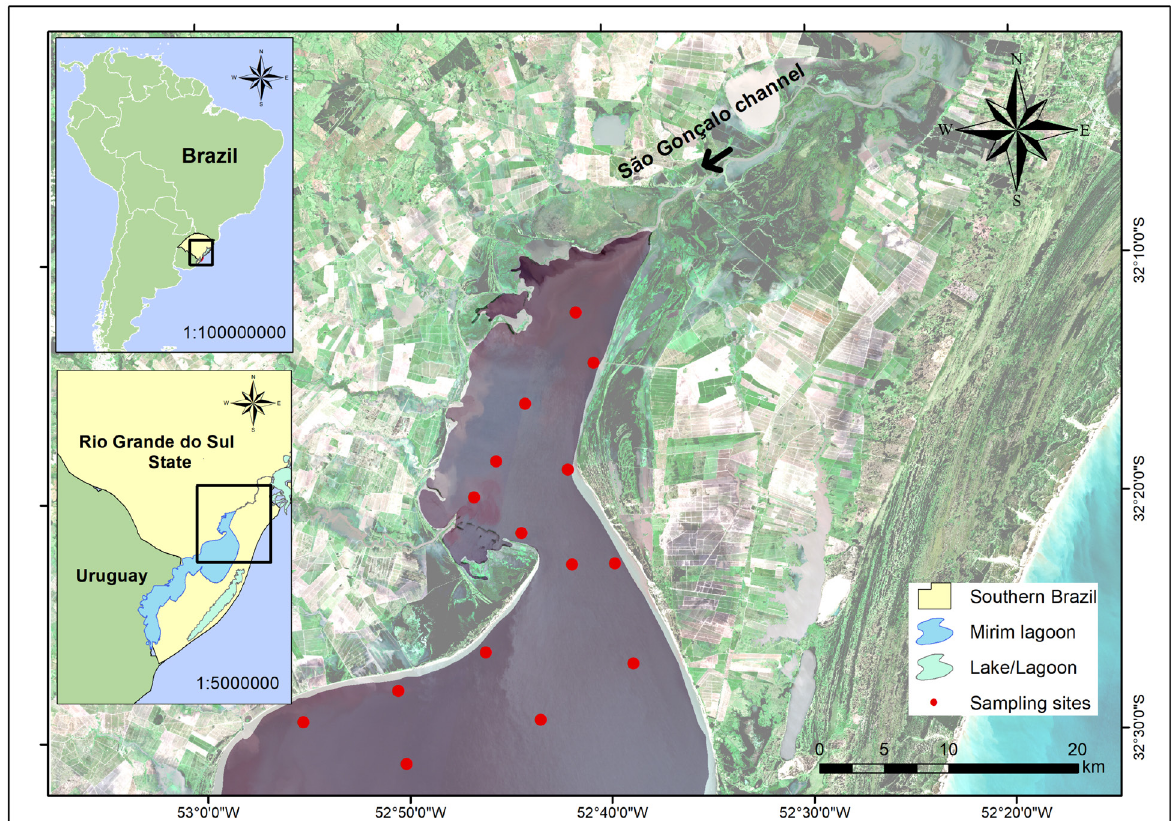
Figure 1. Location of the Mirim lagoon in Southern Brazil. R (4) G (3) B (2) composition of the Mirim lagoon image from the MSI sensor onboard the Sentinel-2 satellite acquired on October 15,